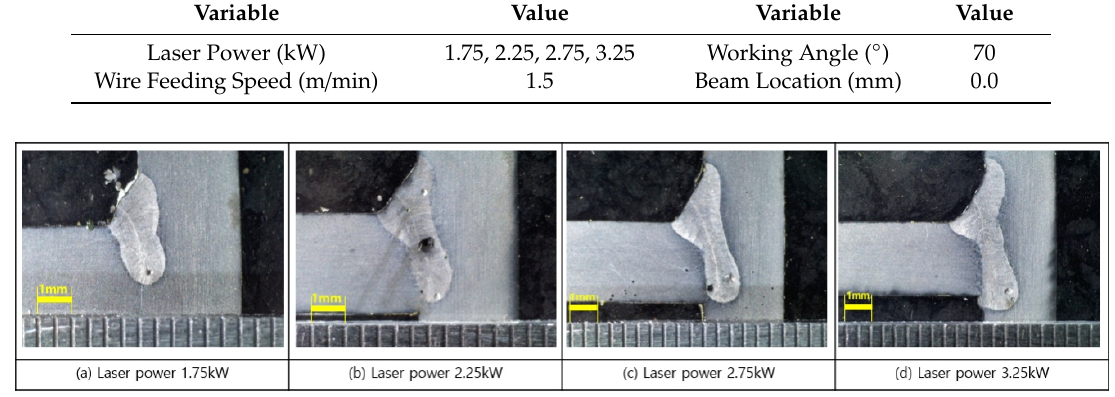
Figure 11. Applying different levels of laser power. Table 9. Welding conditions of Step 2 (laser power change, beam location change, 6 cases).